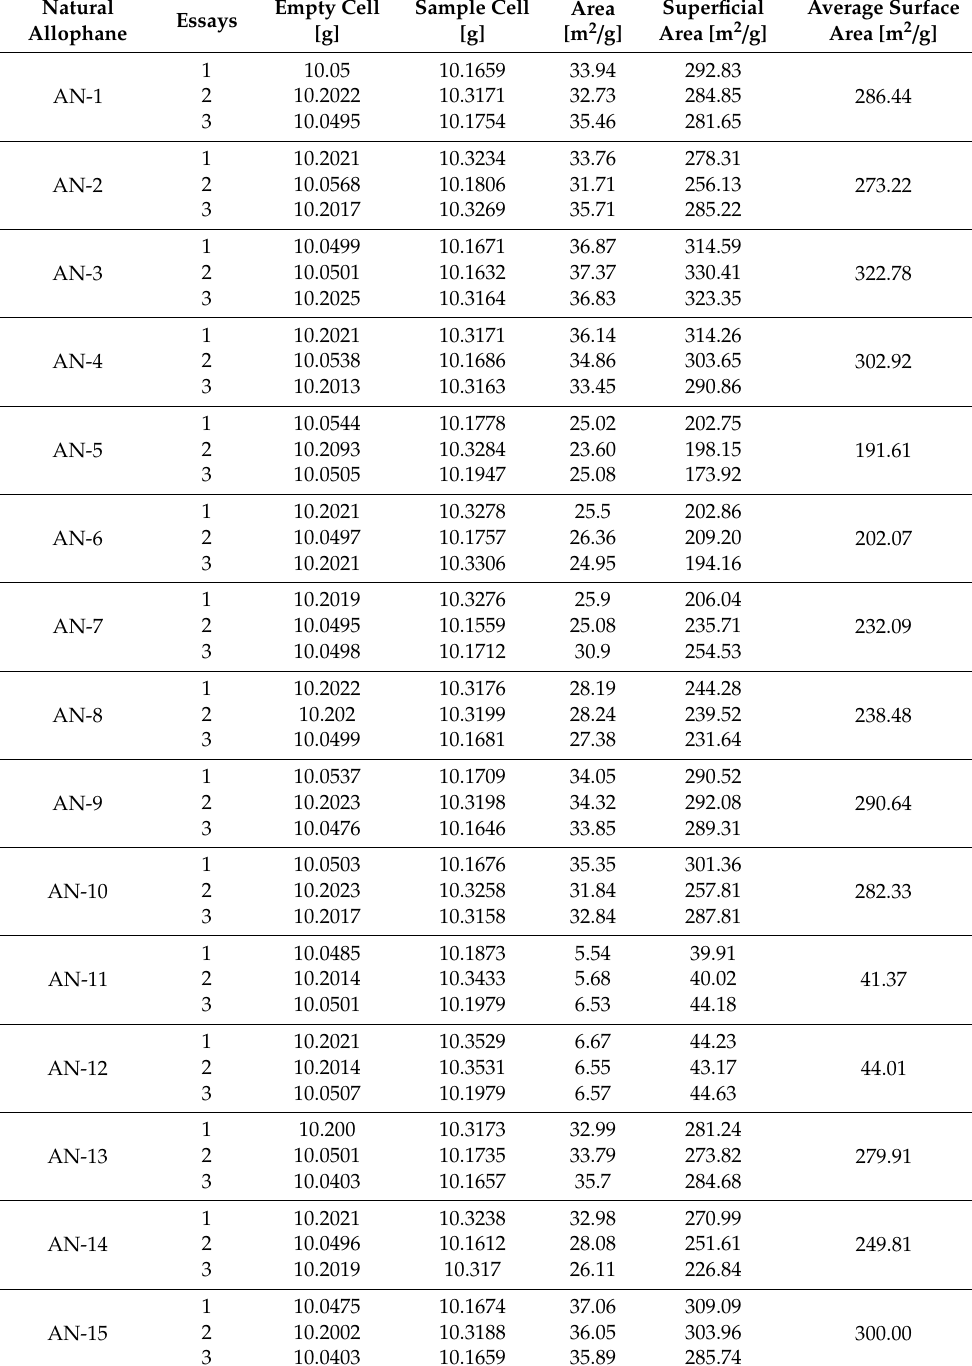
Table 3. BET surface area calculations (pure